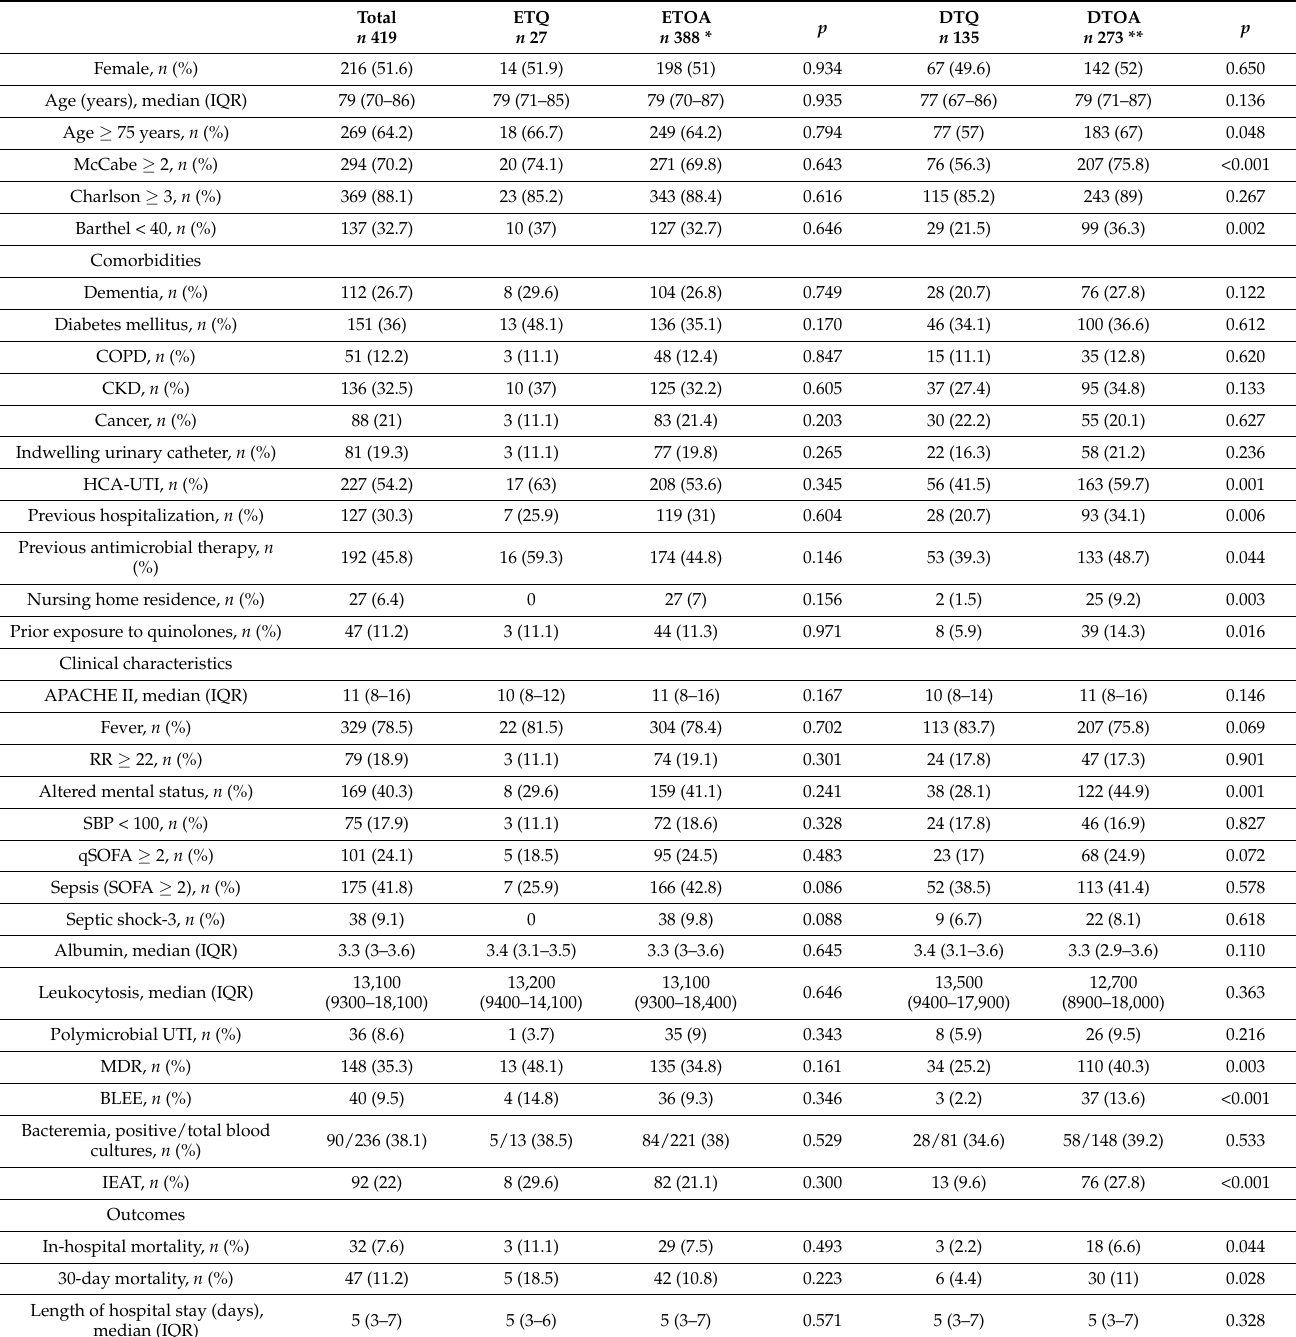
Table 1. Epidemiological and clinical characteristics and outcomes of community-acquired urinary tract infection according to use of fluoroquinolones as empiric or directed antibiotic